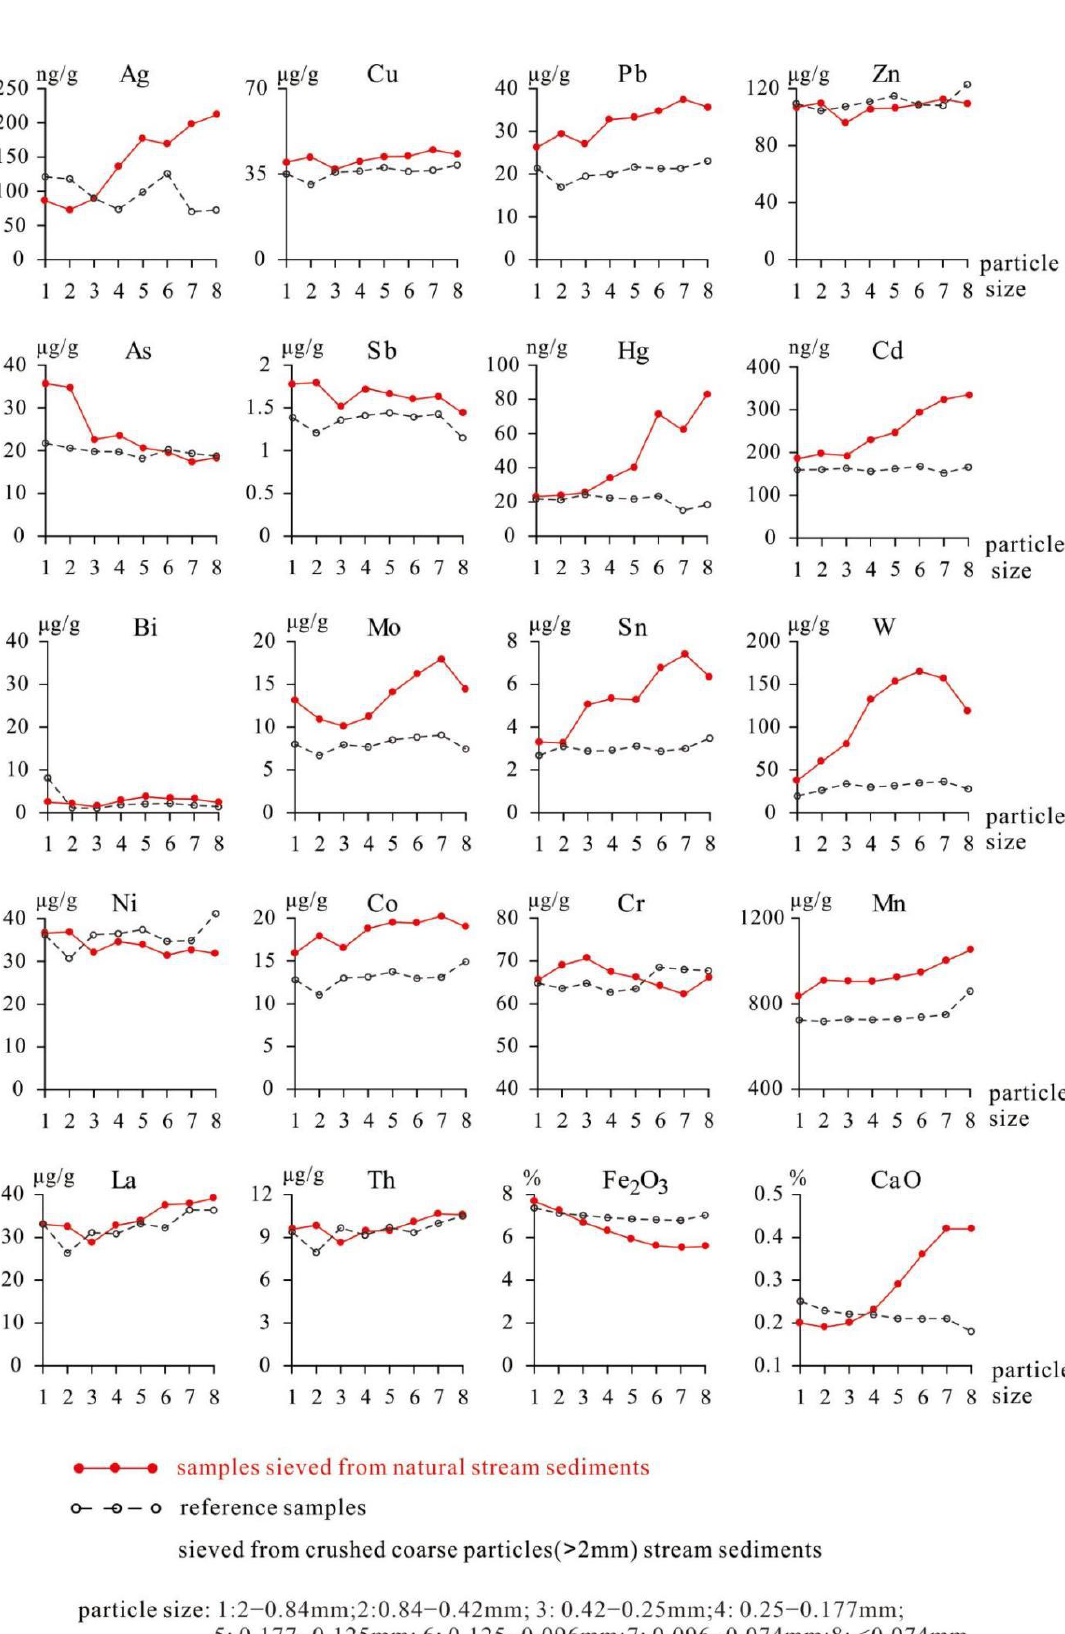
Figure 3. Element distributions in the different particle size fractions of stream sediments (JSL1).